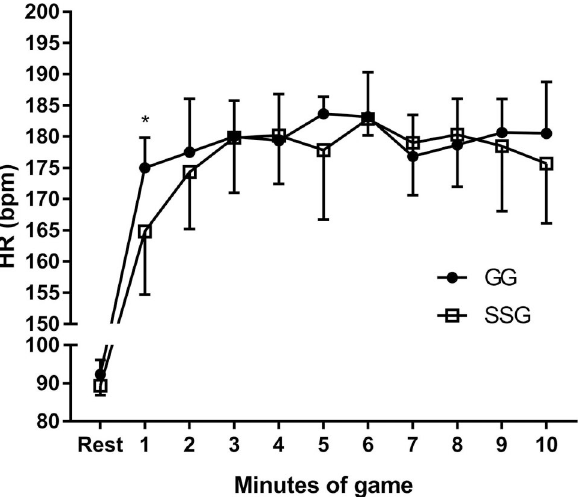
Figure 3 - HR comparison between GG and SSG at rest and every mi- nute. Data expressed as mean ± standard deviation. * - significant differ- ence with